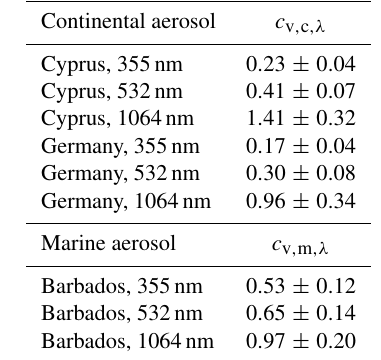
Table 3. Extinction-to-volume conversion factors for non-dust com- ponents (continental aerosol pollution, marine aerosol) required in Eqs. (19)–(20) in Sect. 4.5. The listed mean values of c v ,i,λ (in 10 − 12 Mm) and SD are computed from averaging of all individual marine or aerosol pollution observations of these conversion factors of carefully filtered marine and aerosol pollution AERONET data sets (marine: Ragged Point, Barbados; aerosol pollution: Leipzig, Germany, and Limassol, Cyprus). See the text in Sects. 4.5 and 5 for more